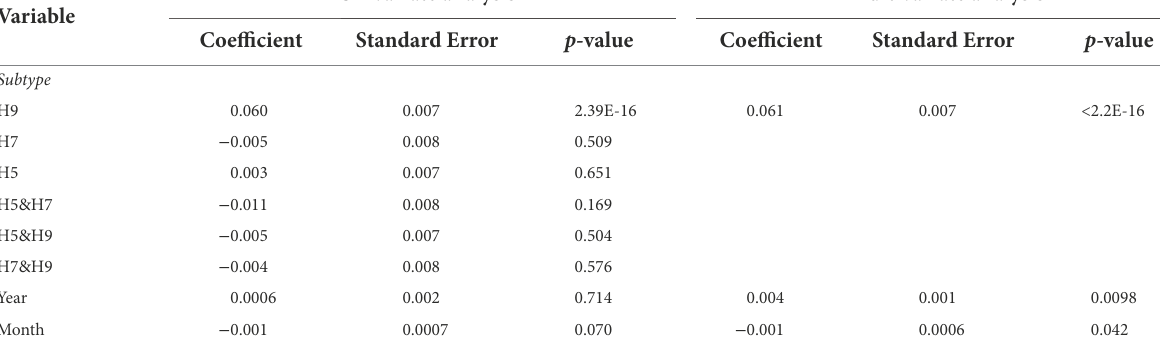
TABLE 1 Univariate and multivariate analysis of the monthly positive rate by